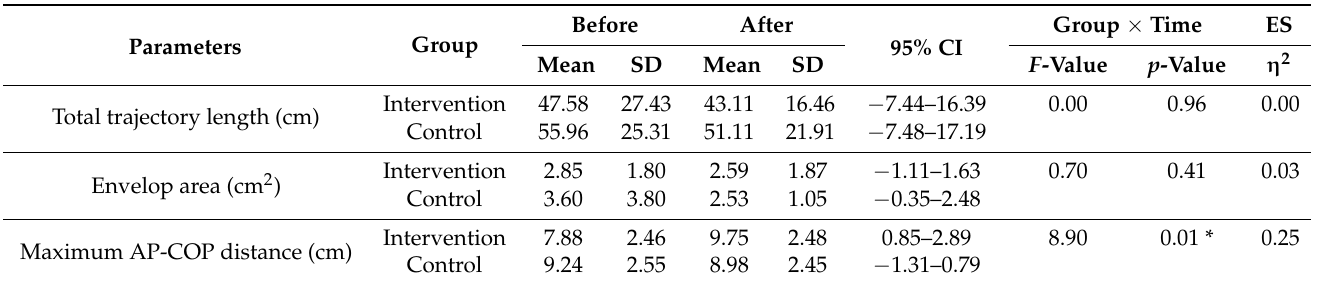
Table 2. Comparison of parameters before and after training in the intervention and control